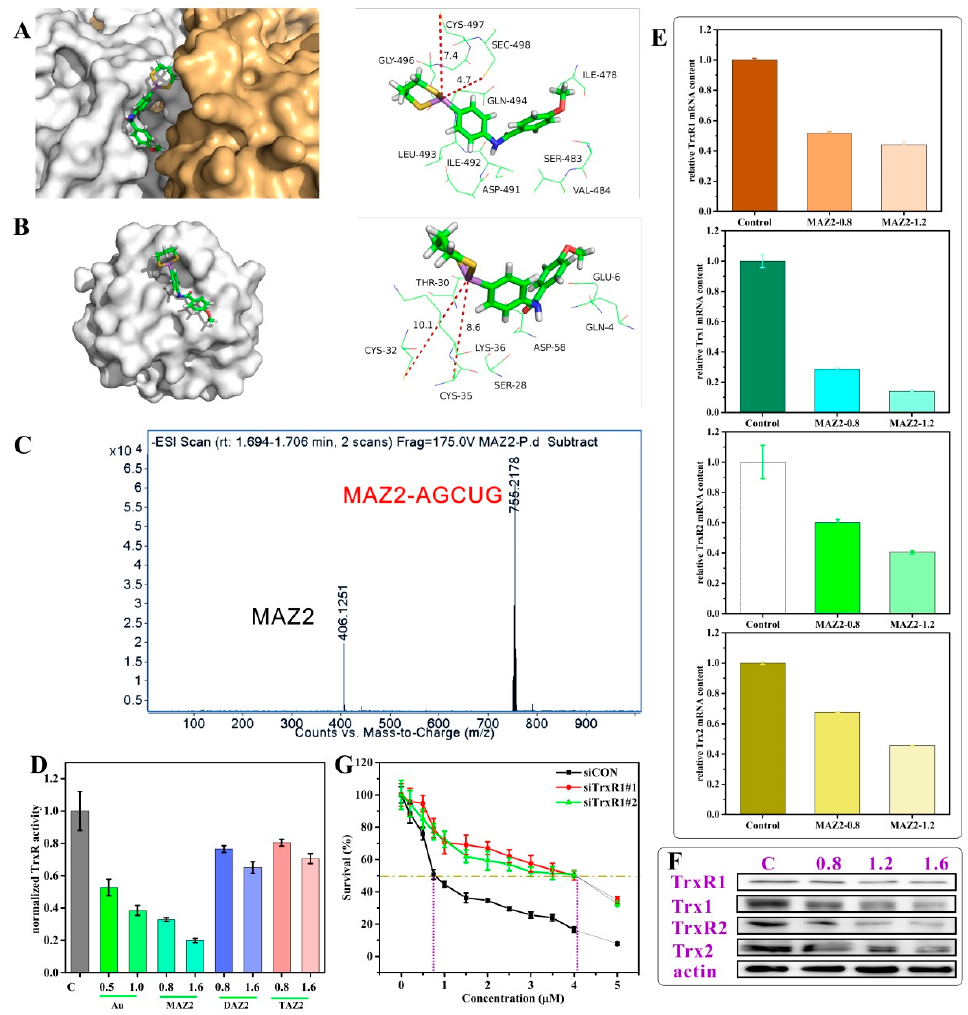
Figure 1. The arsenicals inhibited TrxR activity by binding to the C–terminal Sec/Cys pair; ( A , B ) show the binding site of MAZ2 in TrxR1 (PDB: 3EAN) and Trx1 (PDB: 1ERT); ( C ) is an MS spectrum of a mixture of the peptide AGCUG and MAZ2; ( D ) is the TrxR activity of the 4T1 cells after a 12 h incubation of compounds (Au: auranofin); ( E ) is the transcription of the Trx system genes of the 4T1 cells incubated with MAZ2 for 24 h at the dosage of 1 IC 50 and 1.5 IC 50 ; ( F ) is the protein content of the Trx system of the 4T1 cells; and ( G ) is an MTT assay of the 4T1 cells with siRNA and MAZ2.